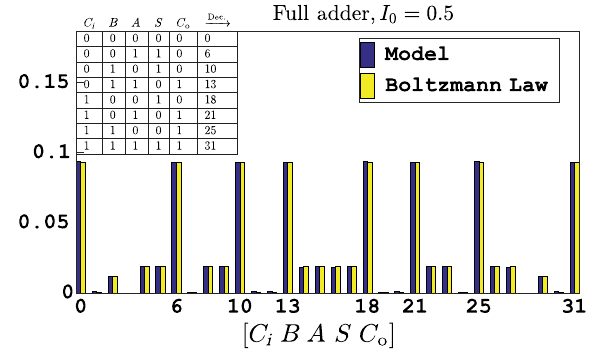
FIG. 9. Noise tolerance of AND. The probability of a wrong output for an (AND) gate [Eq. (15)] operated with clamped inputs FIG. 10. Full adder. Full adder in the truth table mode, where is investigated in the presence of a random noise field which all inputs and outputs are floating, calculated using J enters Eq. (2) as indicated in the figure. The noise is assumed Eq. (16), with I 0 ¼ 0 . 5 . The statistics are collected for T ¼ 10 6 steps, and each terminal output is then placed in the to be uniformly distributed over all p -bits in a given network, ~ h histogram. The states are numbered using the decimal number and centered around zero with magnitude (cid:3) n , where corresponding to the binary number ½ C i A B S C o (cid:2) . The ð I 0 ¼ 2 ; h i ¼ (cid:3) 1 Þ . Each gate is simulated 50 000 times for T ¼ 100 time steps to produce an error probability for a given decimal numbers corresponding to the truth table are shown in the inset, and these match the location of the taller peaks in the noise value, and the maximum peak produced by the system is histogram. Note that the Boltzmann distribution [Eq. (4)] quan- assumed to be an output that can be read with certainty. The system titatively matches the model even for the suppressed shows robust behavior even in the presence of large levels of noise.